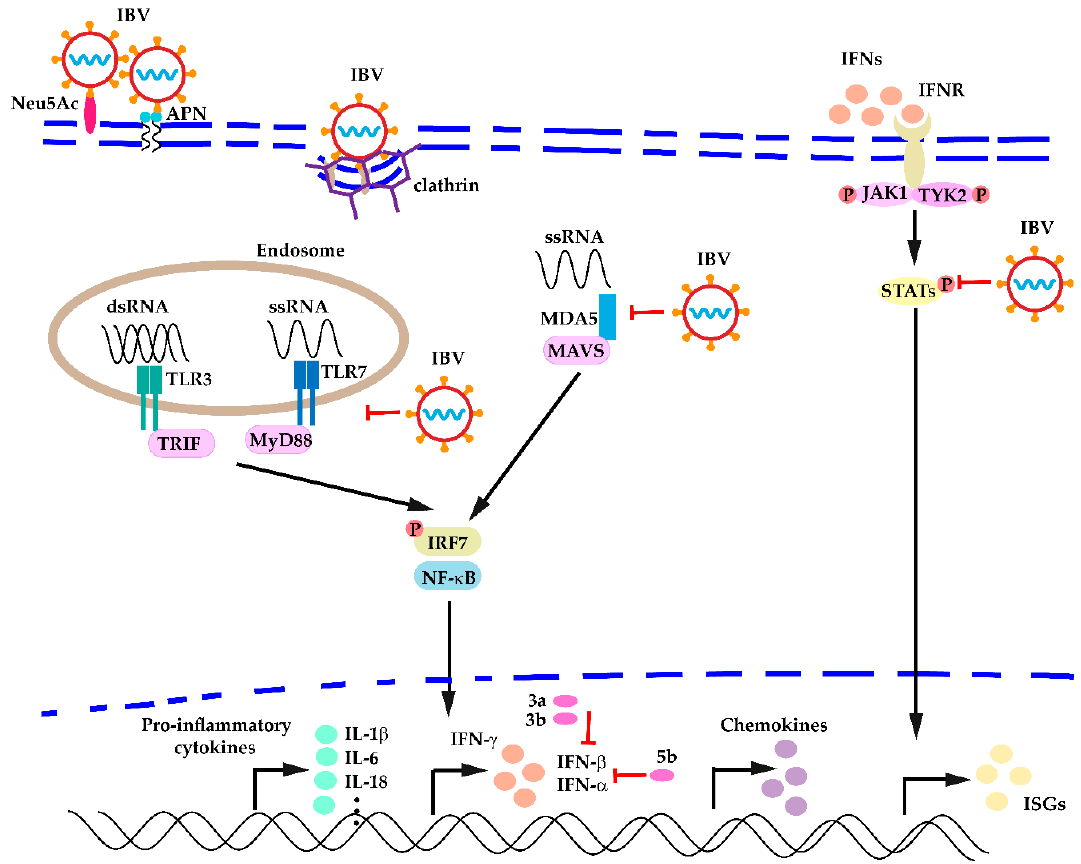
Figure 1. A general description of host innate immune responses against IBV infection.